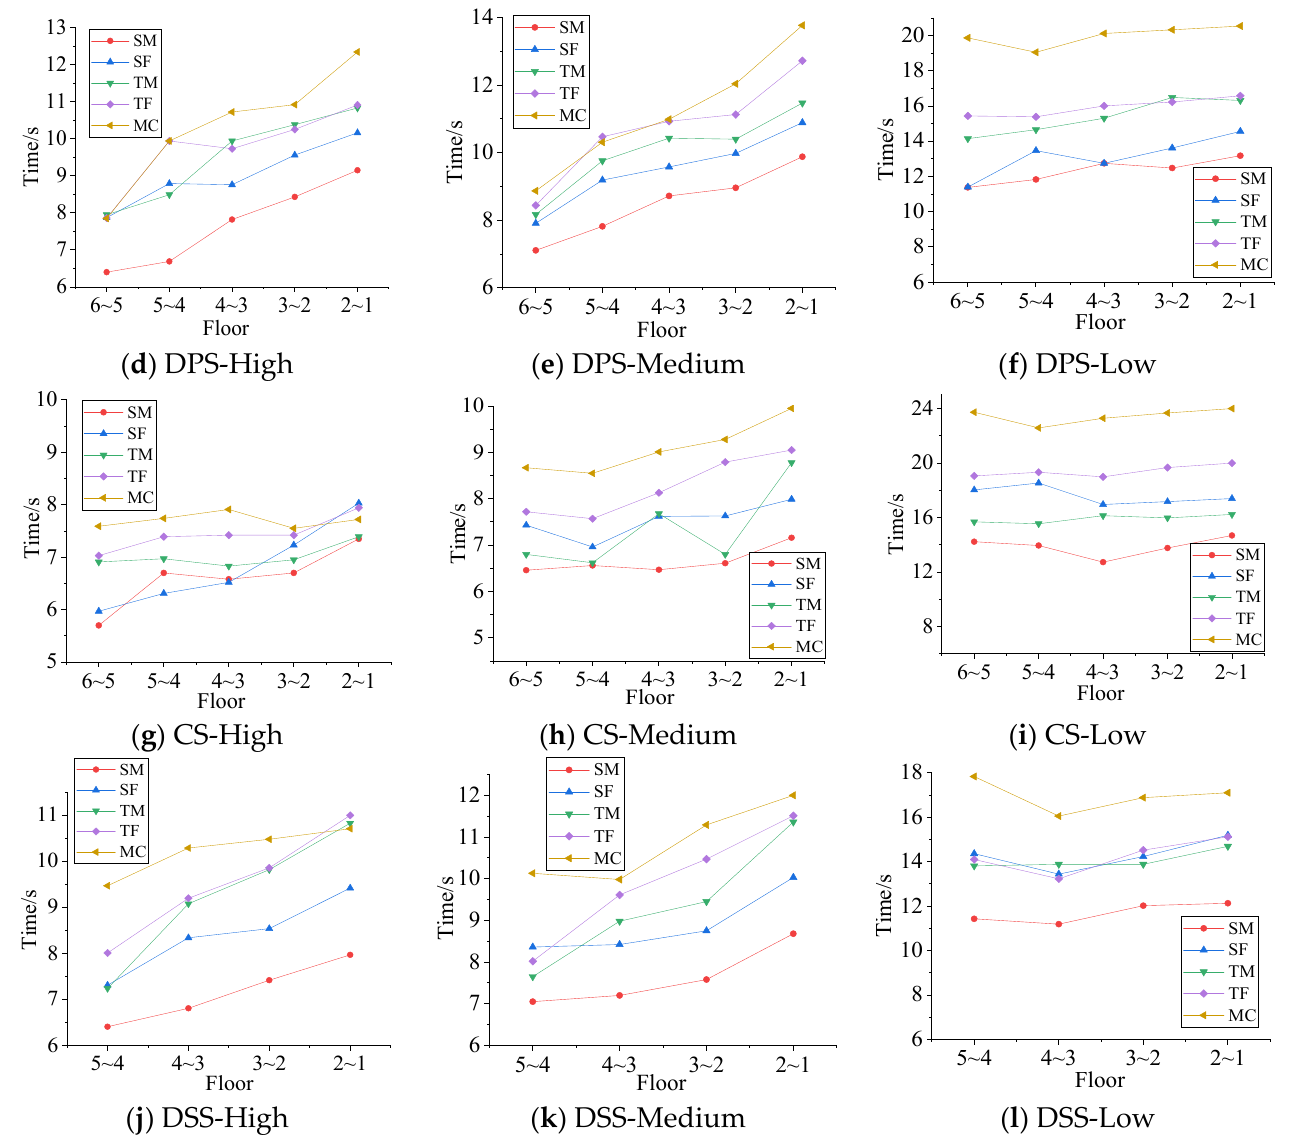
Figure 5. Time distribution of various staircases and scenarios.